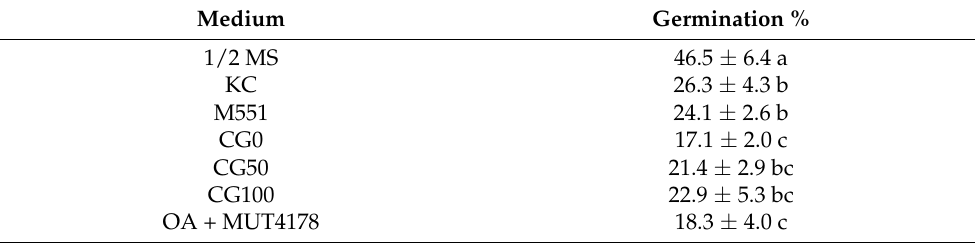
Table 1. Germination mean percentages ( ± Standard Error) ( n = 8) recorded 70 days after seed sowing of Cattleya purpurata . Data were analyzed by ANOVA followed by Fisher’s probable least- squares difference test with cut-off significance at p ≤ 0.001. Percentages with the same letters are not significantly different from each